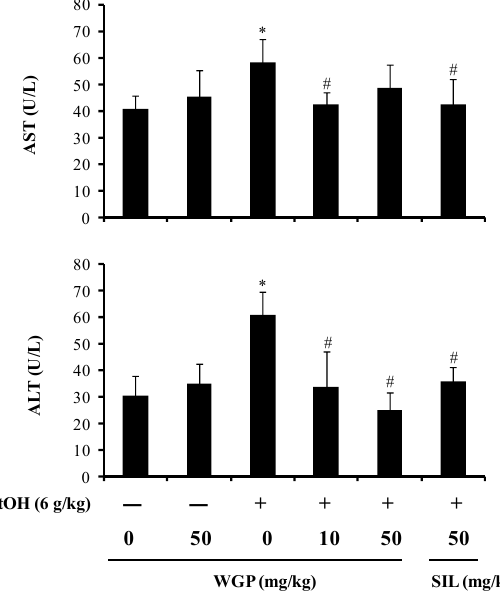
from the ethanol-treated group.